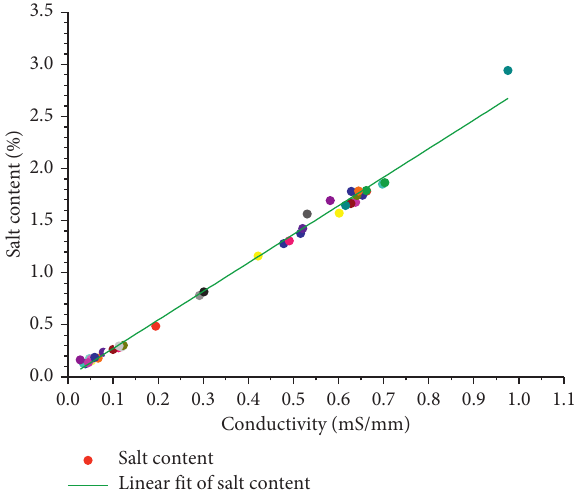
Figure 4: Relationship between salt content and conductivity of the local saline-alkali soil.